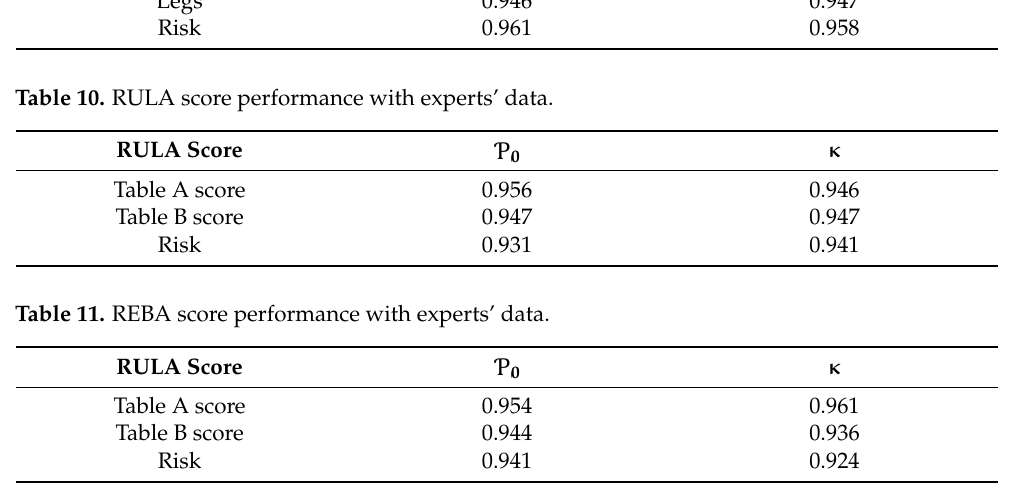
Figure 3. Good posture image with high reliability.